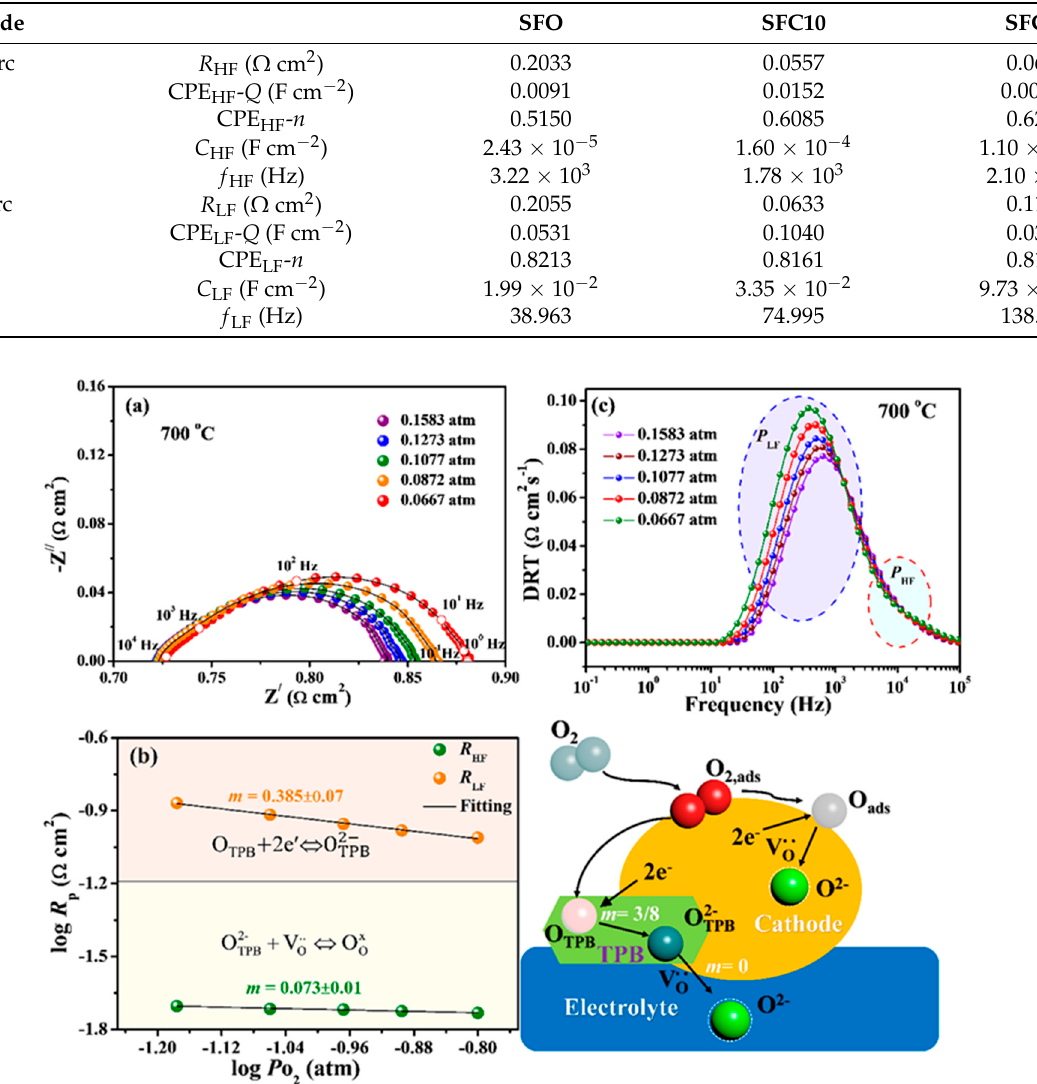
Figure 7. ( a ) Impedance spectra of the SFC10 electrode under various P o 2 at 700 °C; ( b ) R HF and R LF of the SFC10 electrode vs. P o 2 at 700 °C; ( c ) DRT curves of SFC10 electrode under various P o 2 .